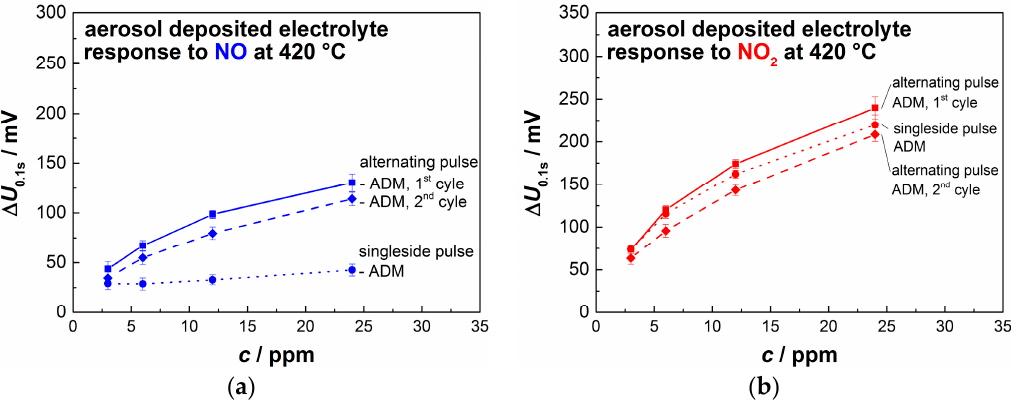
Figure 9. Sensor characteristics for sensors based on 8YSZ electrolytes built by aerosol deposition with overlying platinum interdigital electrodes towards small concentration of ( a ) NO and ( b ) NO 2 .